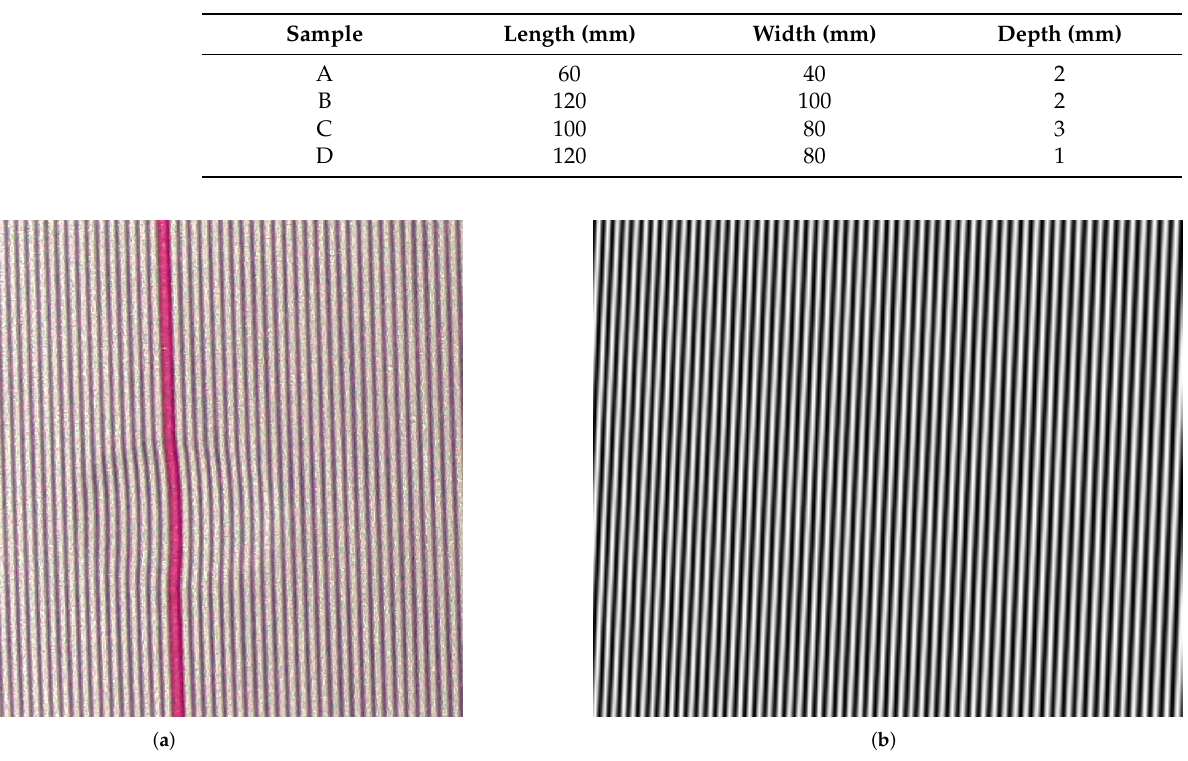
Figure 14. Input images for sample A. ( a ) Captured object image. Red values are converted to greyscale before FFT. ( b ) Virtual reference